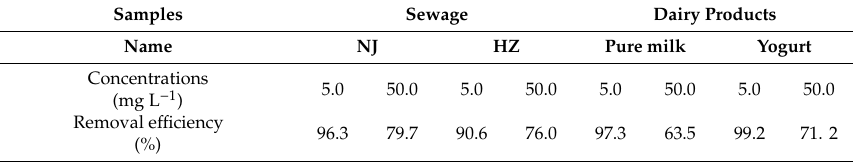
Table 4. Results of removing tetracycline from sewage and dairy products with MOF 1.